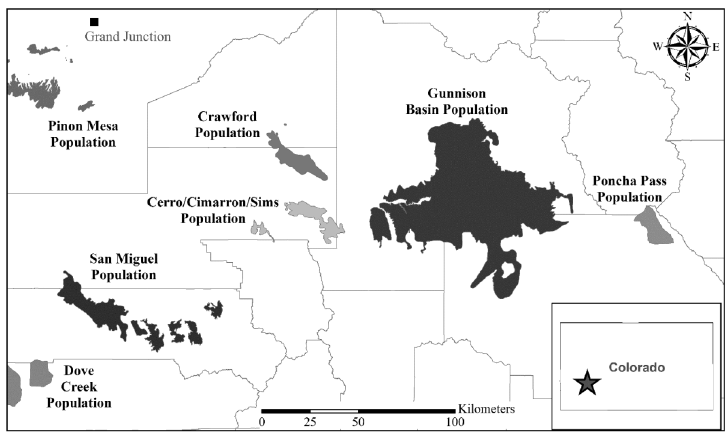
Fig 1. The distribution of seven isolated populations of Gunnison Sage-Grouse in Colorado, USA. The two study populations (Gunnison Basin and San Miguel) are shaded black. County boundaries are provided for